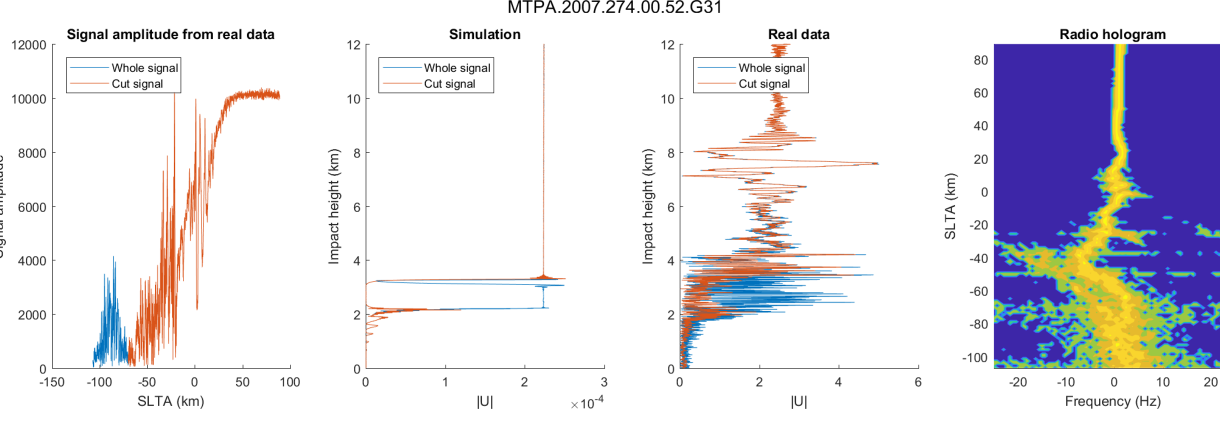
Figure 8. An event classified as category 3. SLTA min is at approximately − 87km, and the signal is truncated at SLTA = − 70km. The reflection spike is located at an impact height of 2075m, and a min is